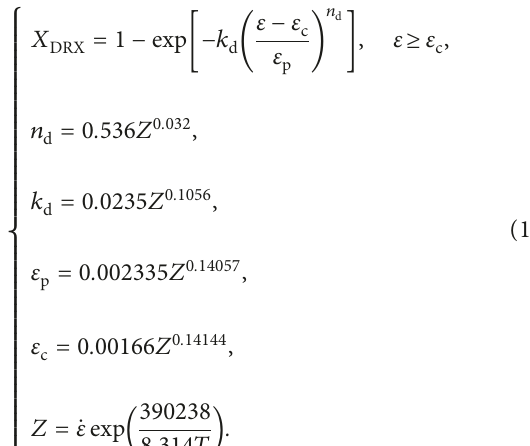
Figure 7: Relationships between (a) ln n ln Z